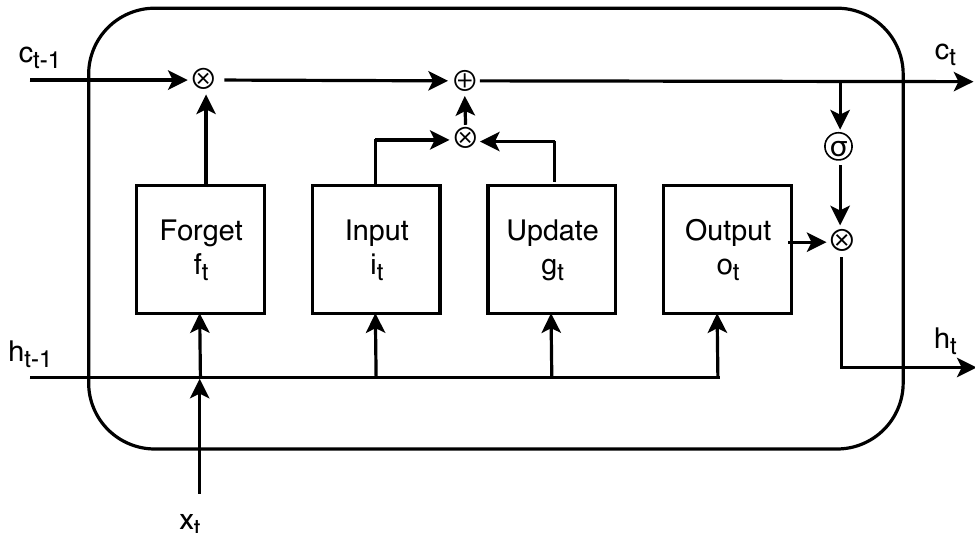
Figure 2. Schematic diagram and data flow for one LSTM